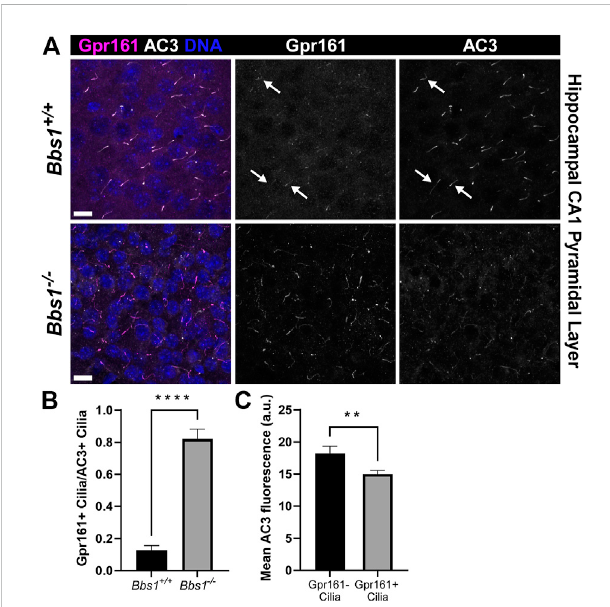
Gpr161 accumulates in cilia in the brains of Bbs1 − / − mice and is associated with a reduction in AC3 ciliary signal (A) Representative images of the ventral CA1 region of the hippocampus from adult Bbs1 +/+ (upper row) and Bbs1 − / − (lower row) mice colabeled for Gpr161 (magenta) and AC3 (white). Note that Gpr161-positive cilia are barely detectable in the Bbs1 +/+ section (indicated by arrows) but prominent in the Bbs1 − / − section (middle panels). Nuclei are stained with DRAQ5 (blue). Scale bars represent 10 µm (B) Quanti fi cation of Gpr161-positive ciliarelativetoAC3-positive ciliareveals asigni fi cant increase inGpr161- positive cilia in Bbs1 − / − sections (889/1,093; n = 3 animals), compared to Bbs1 +/+ sections(91/959; n =3animals) (C) Quanti fi cationofmeanciliary AC3 fl uorescence in Gpr161-negative ( n = 74) and Gpr161-positive ( n = 170) cilia in Bbs1 − / − sections. Note that the AC3 signal is signi fi cantly lower in Gpr161-positive cilia. Values are expressed as mean ± SEM. ** p < 0.01 **** p < 0.0001.